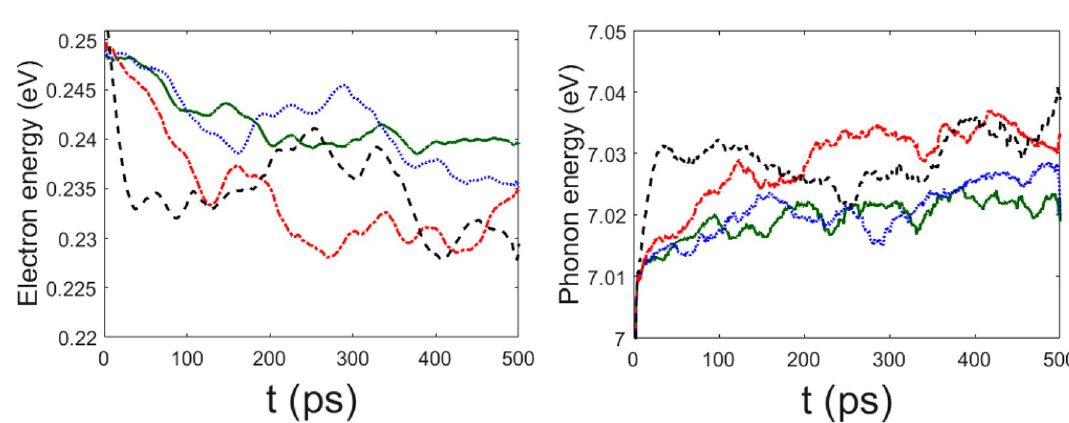
Figure 3. Time evolution of the average displacements along the chain of N values are the same of Fig. 1. Time t is measured in 10 −